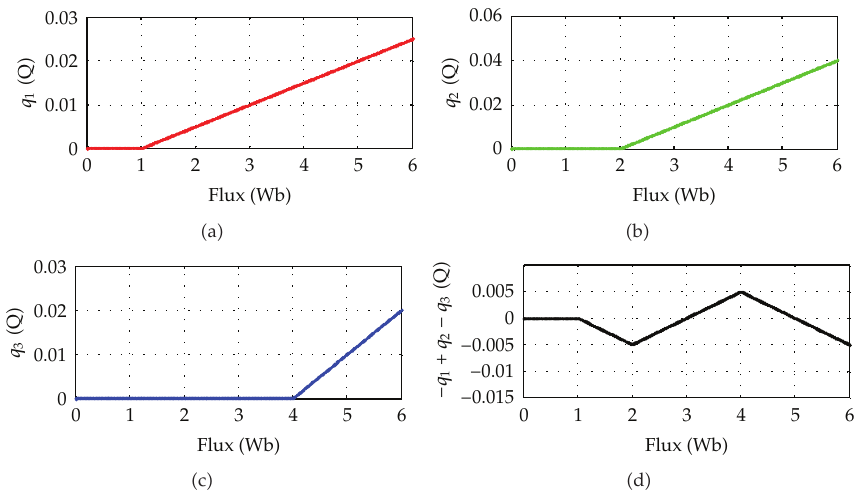
Figure 4: The curves of q − ϕ relation in the memristive parallel